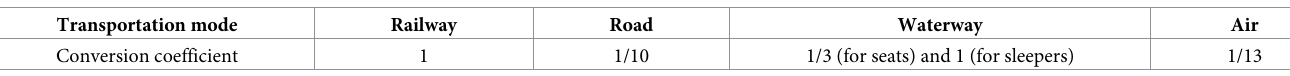
Table 2. Conversion coefficients used in comprehensive concerted